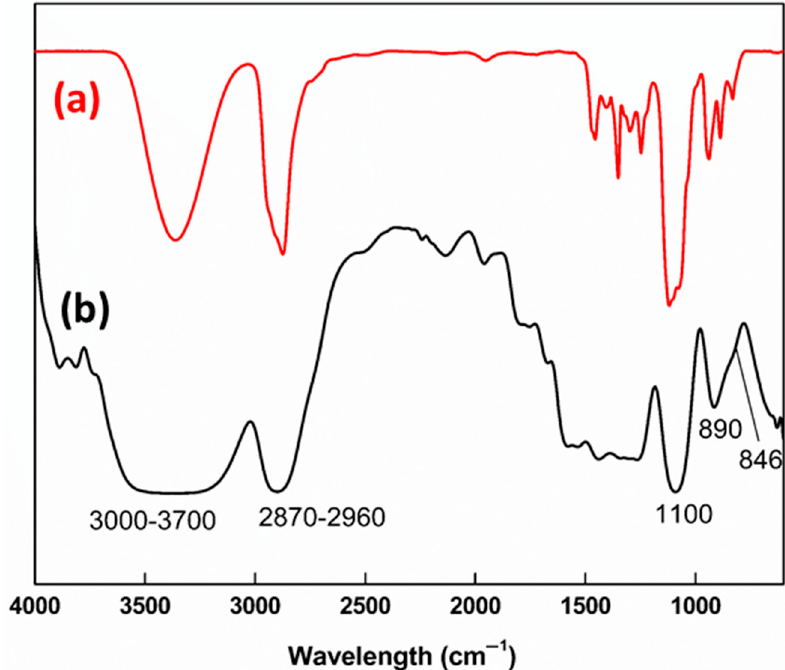
Figure 3. Fourier-transform IR (FT-IR) spectra of ( a ) pure PEG200 and ( b ) PEG 200 @PU MCs.